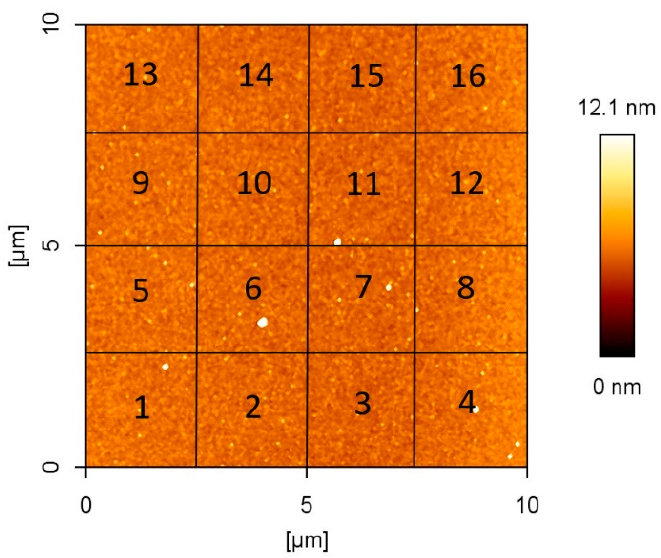
Figure 7. The image of gold thin film obtained by Gwyddion software.